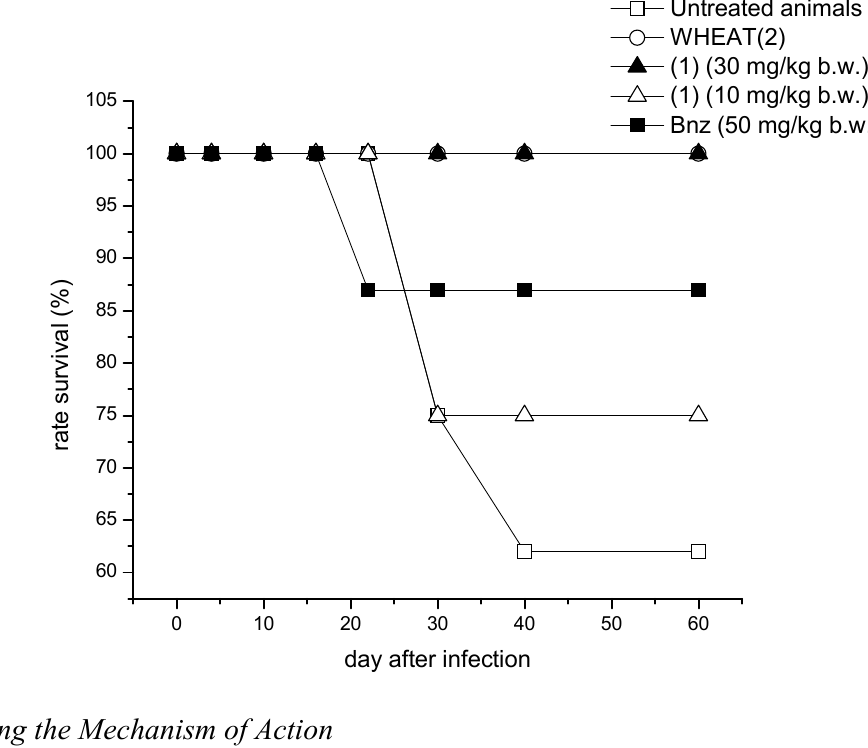
Figure 3. Survival rates in the in vivo activity assays. Eight animals were used in each experimental